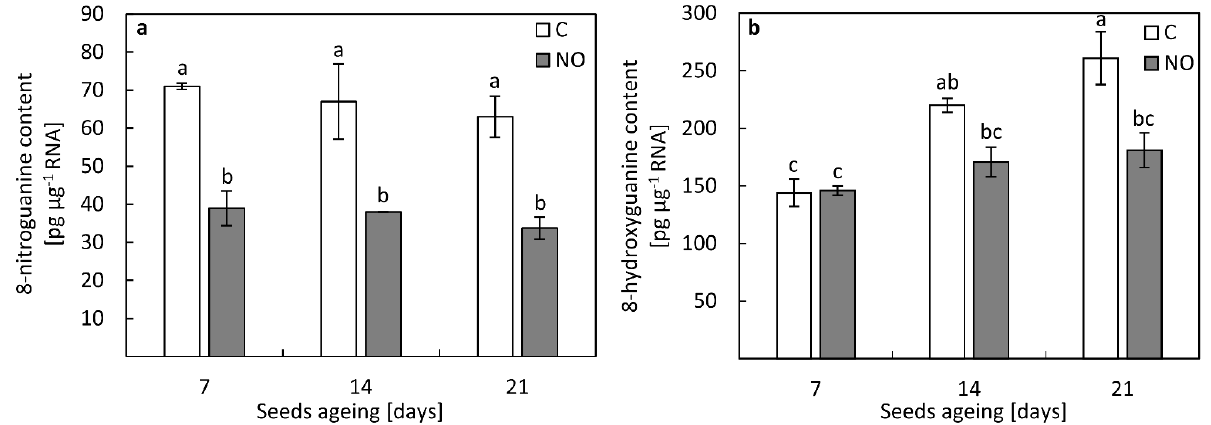
Figure 7. ( a ) The levels of nitrated and ( b ) oxidised RNA in the axes of apple embryos isolated from seeds subjected to accelerated ageing for 7, 14 and 21 days (C) or embryos isolated from aged seeds and treated with NO (NO). Values are average ±SD of 3–5 independent repetitions. Different letters indicate significant differences obtained by Tukey’s test ( p < 0.05).